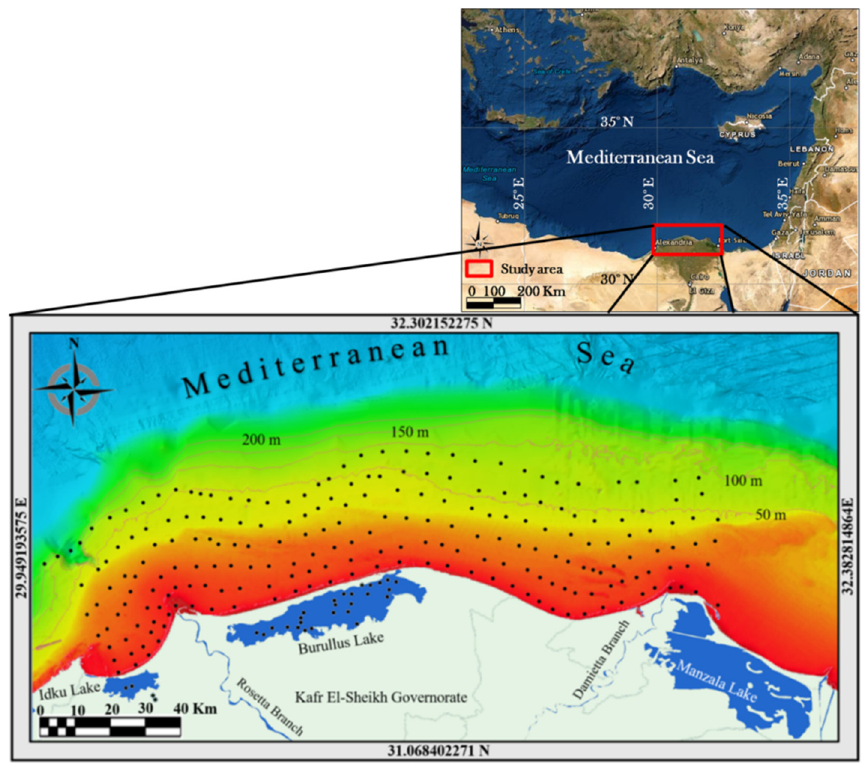
Figure 1. Location map of the study area. Sampling points used for regression analysis is shown in black filled circles. Bathymetry data with 50 m contour interval are of GEBCO. The inset map is a courtesy of the world imagery of ESRI.